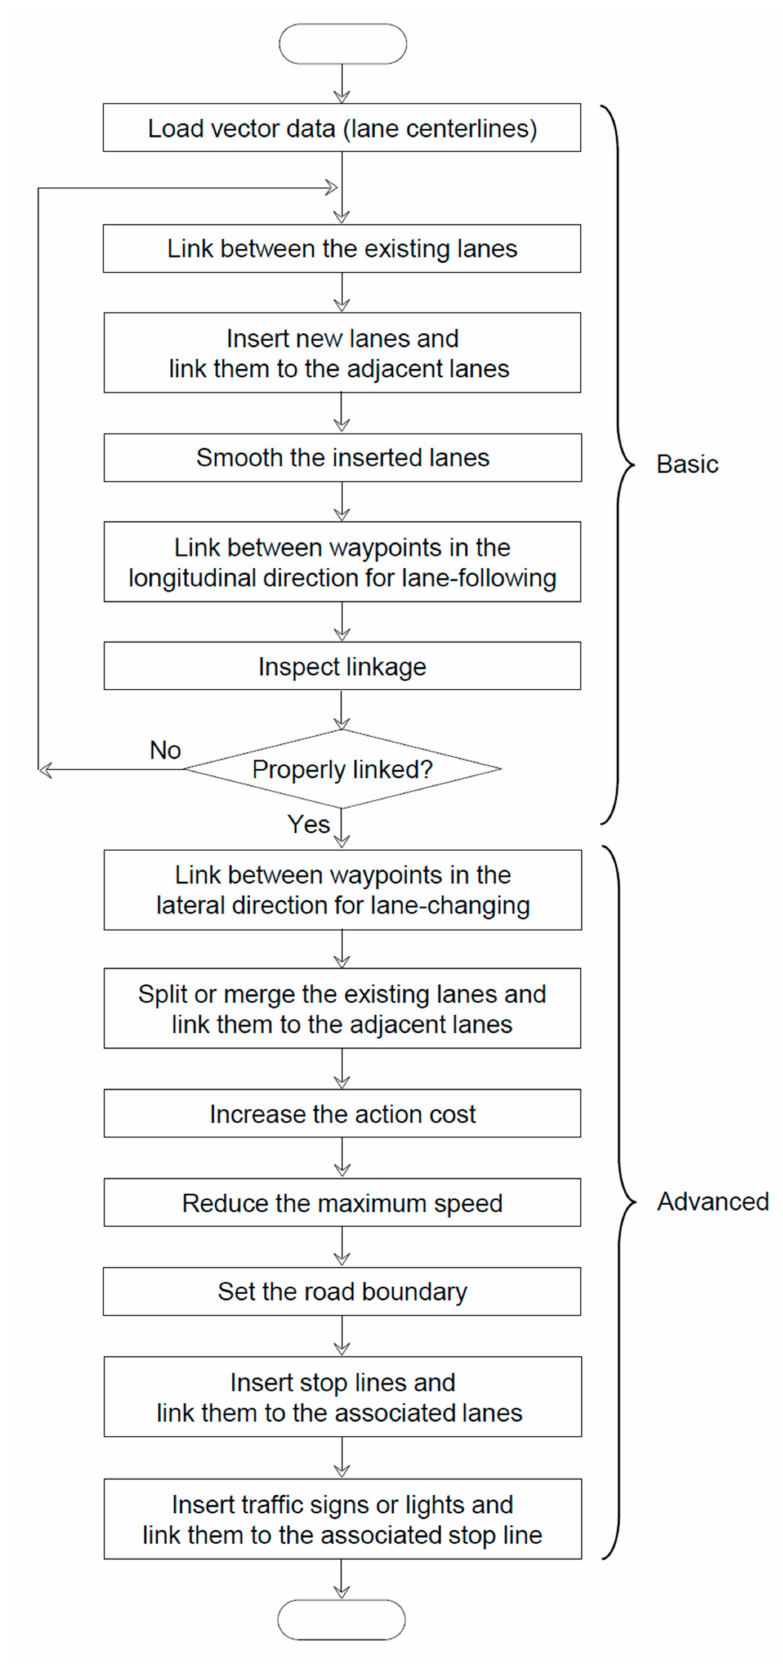
Figure 10. Detailed flowchart of the mapping